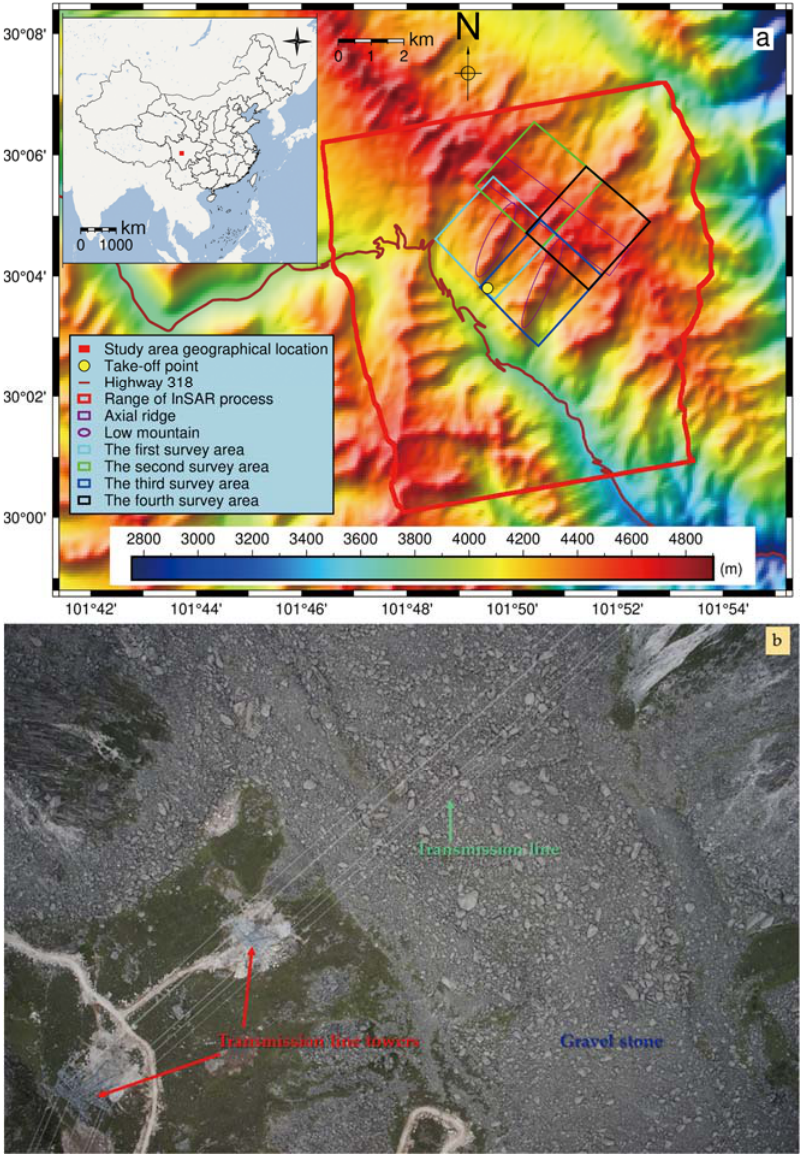
Figure 1. A geographical overview of the study area: ( a ) the topography of the study area, based on the TerraSAR-X add-on for digital elevation measurement (TanDEM) and the study area within a larger map of China (Zheduoshan Mountain in Sichuan Province, China); and ( b ) a photo of the standing transmission line towers, mainly covered with gravel